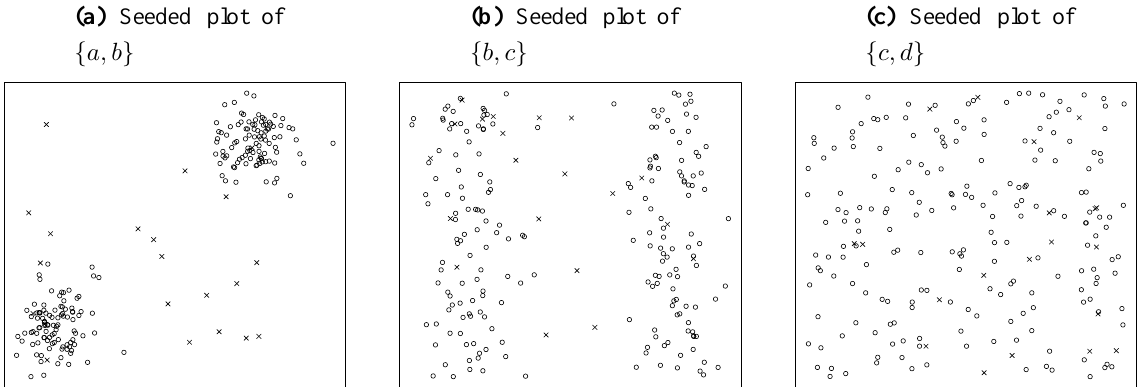
Figure 5. The effect of seeding. Circles are original points and crosses are the artificially injected noise